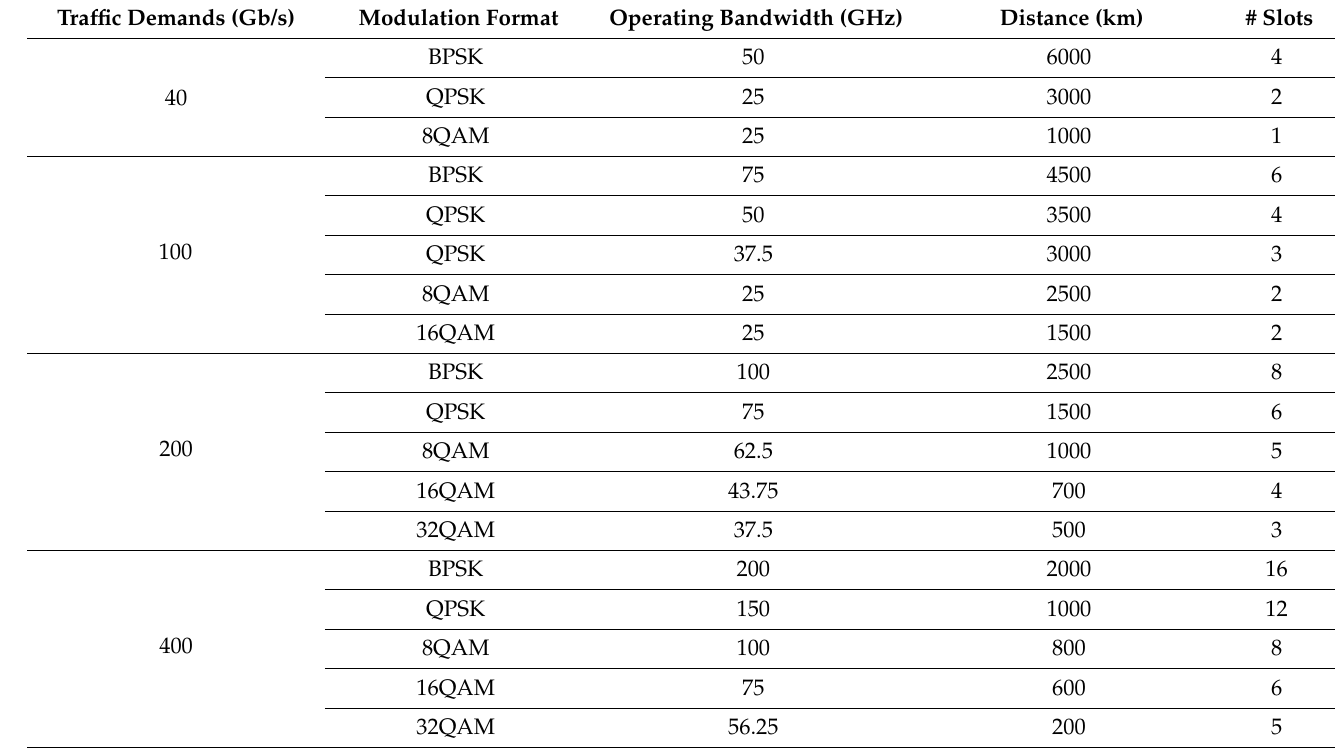
Table 2. Distance and Spectrum Occupation for Various Bit Rates in